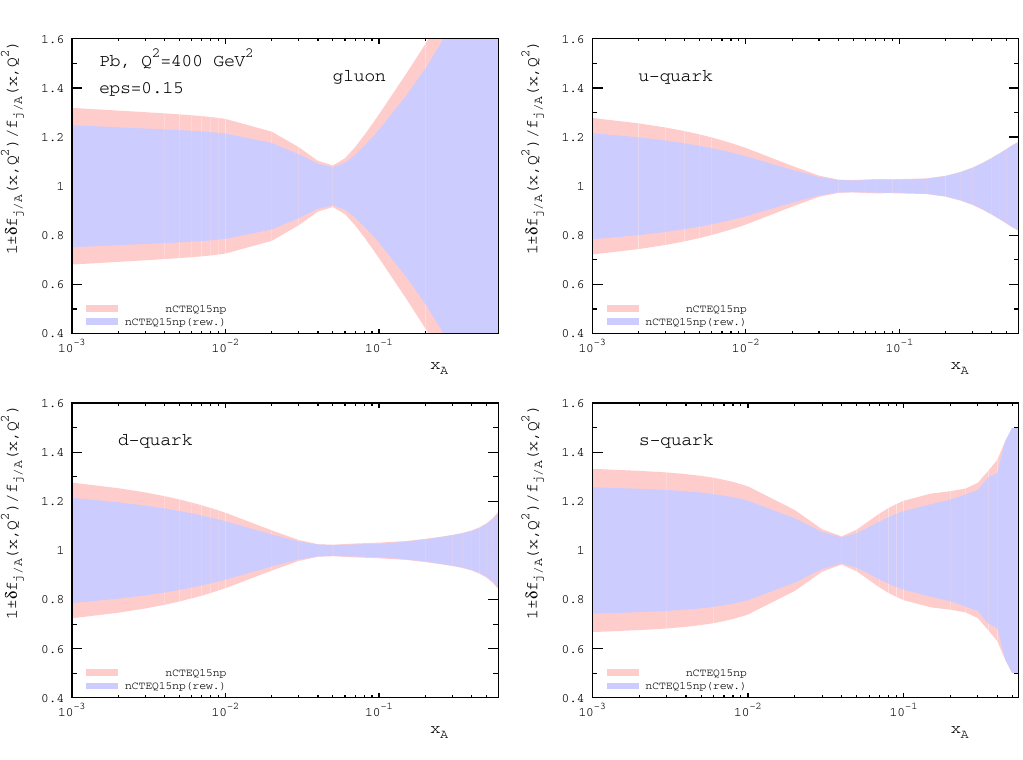
Fig. 8 The same as Fig. 6, but with (cid:6) = 0 .